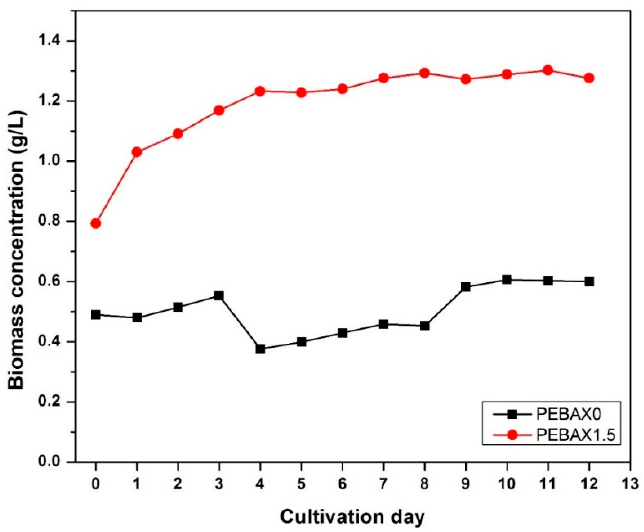
Figure 11. Biomass concentration (g/L) of microalgae for PEBAX0 and PEBAX1.5 throughout 12 days of cultivation .